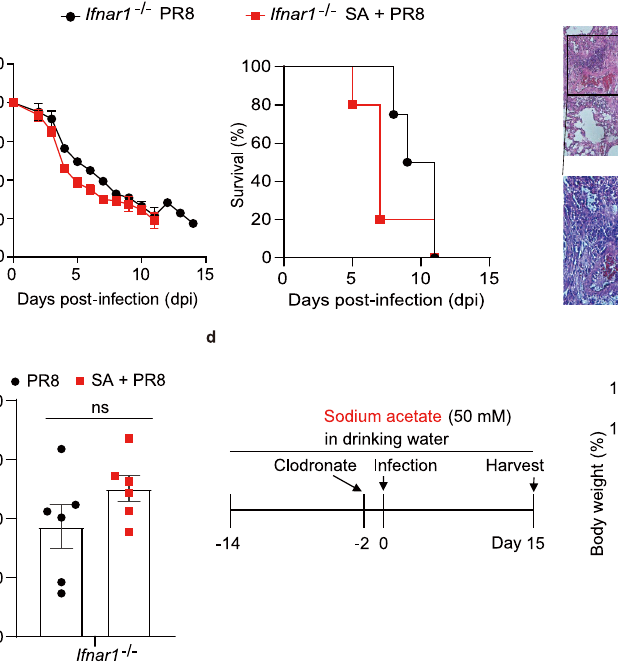
Fig.4|AcetateprotectsagainstIAVinfectioninanIFNAR1-dependentmanner. a Ifnar1 − / − mice pretreated with sodium acetate (SA) ( n =10) or drinking